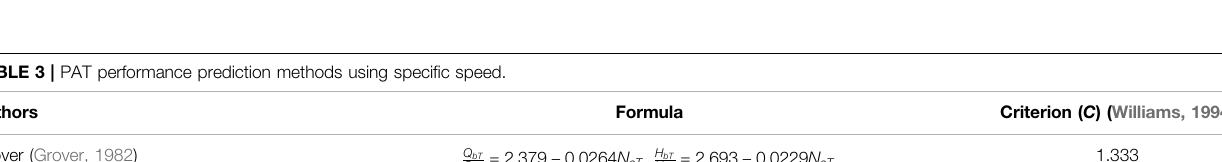
FIGURE 2 | Comparisons between experimental and predicted results from various methods (Huang et al., 2017). (A) GDD80-20, (B) IS100-65, (C) GD100-21.